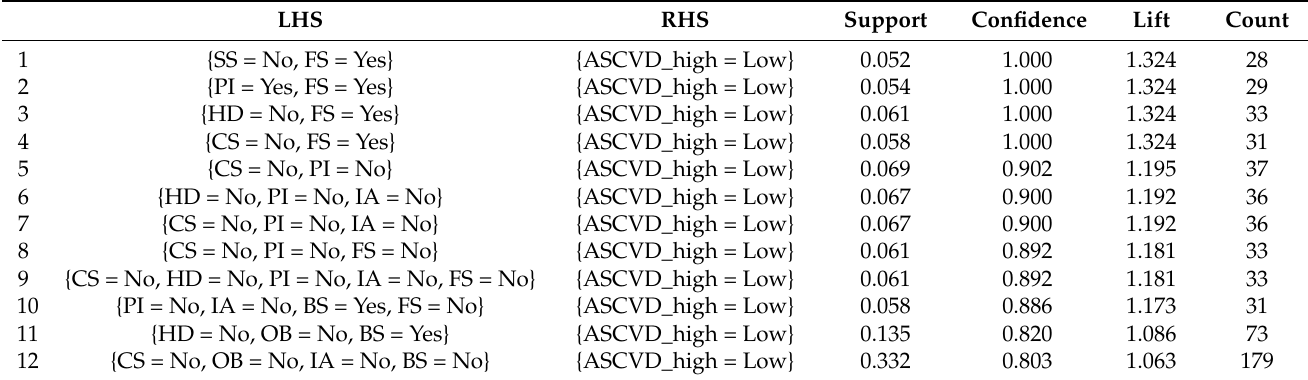
Table 3. Results of a priori algorithms of for ASCVD score in male cancer